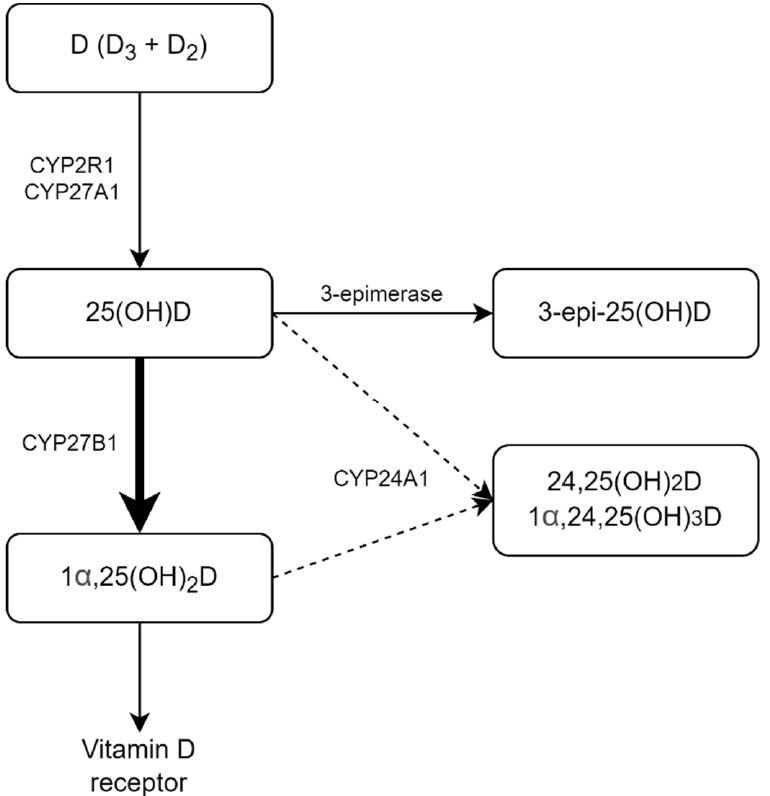
Figure 3. Schematic representation of the observed dysregulation of vitamin D metabolism in COVID-19 patients.